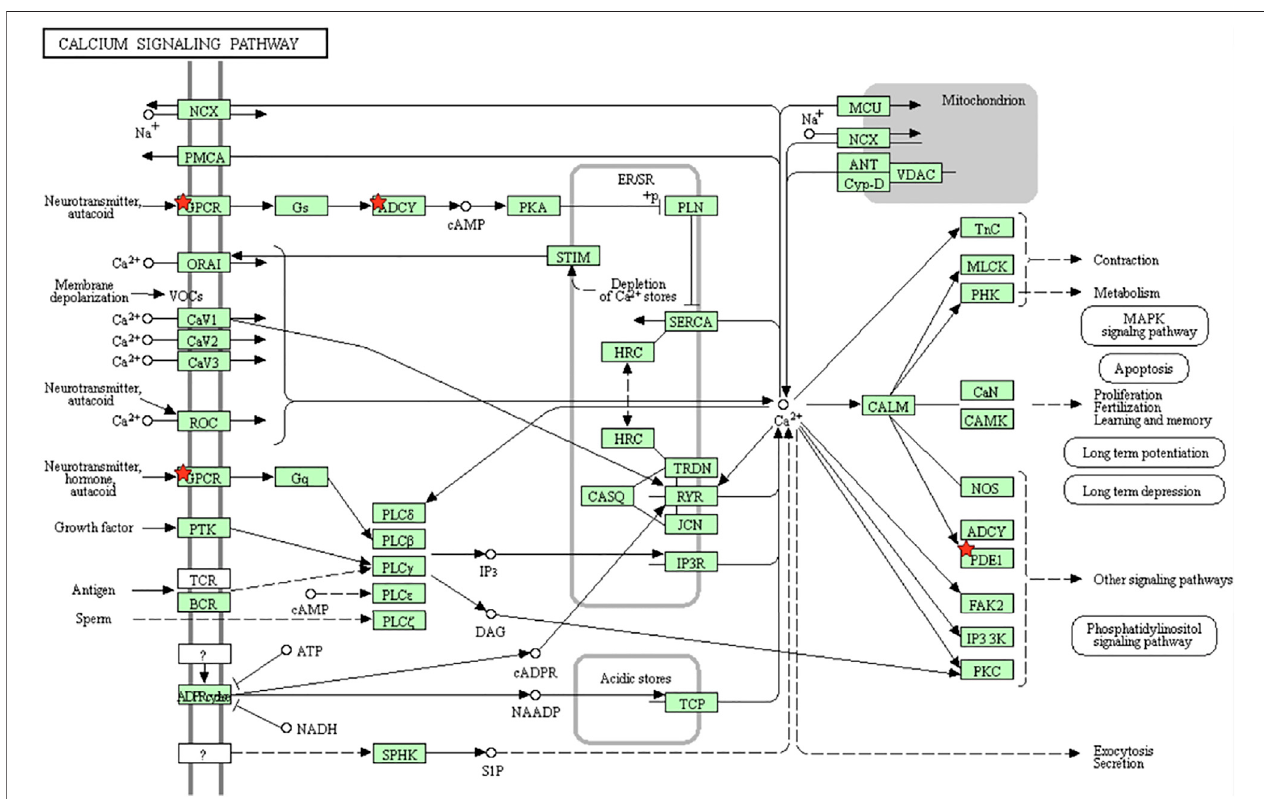
FIGURE 3 | Overview of the Calcium signaling pathway. The red stars in the fi gure are the molecules in the module that hit the signaling pathway.